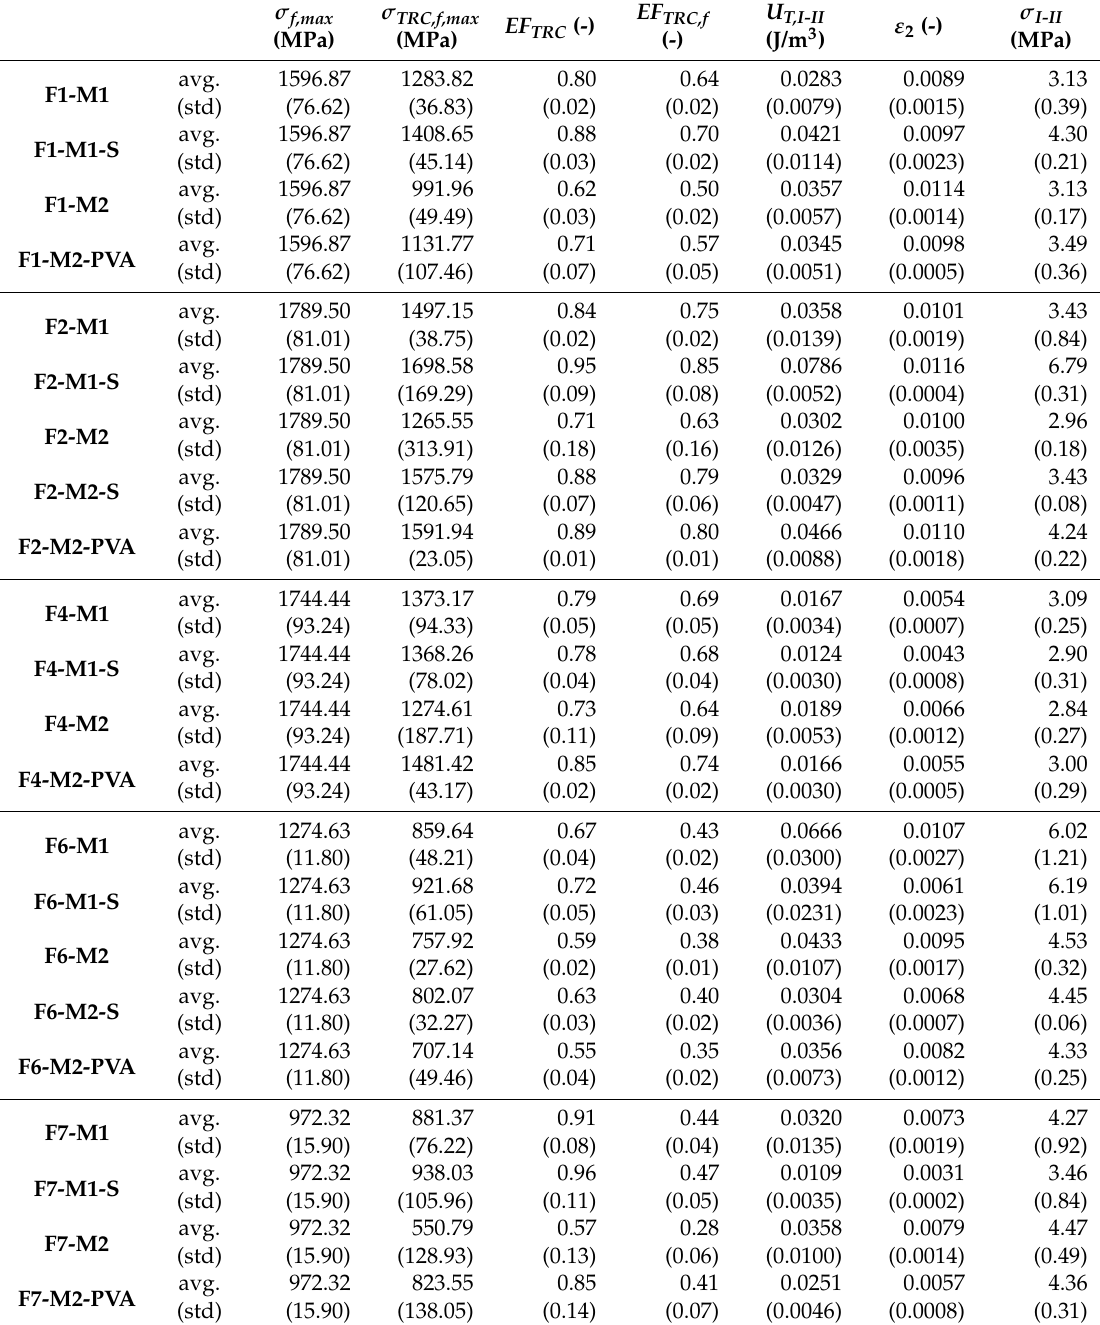
Table 8. Relevant mechanical parameters for TRC composites under uniaxial tension: average values (avg.) and standard deviations